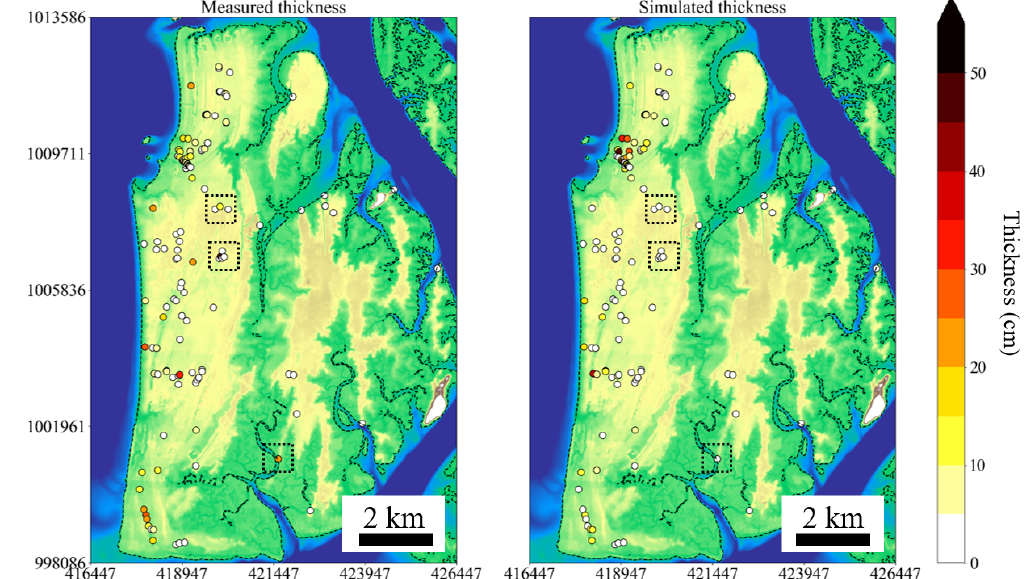
Figure 8. Spatial distribution of measured and simulated thickness of tsunami deposits. The black dotted lines indicate that the calculated values are underestimated at distances greater than 2km.